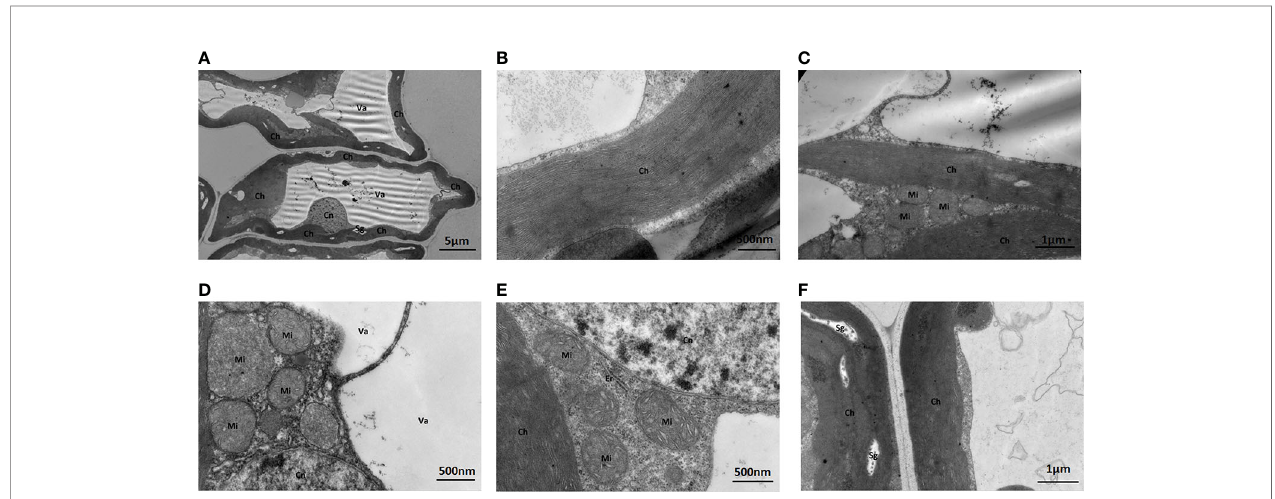
FIGURE 6 | Effect of solid MS culture medium with Na 2 MoO 4 on cell morphology and ultrastructure in leaf of strawberry seedlings. (A) The whole cell with organelles. (B) Stroma lamella and grana lamella in chloroplast. (C) the well developed chloroplasts. (D) the well-developed membrane of Mi and Cn, with mitochondrial cristae. (E) Er, Mi, Cn, and Ch of strawberry seedling grown with MoO 42- (F) The well-developed chloroplast with several Sgs. Ch, chloroplast; Cn, cell nucleus; Er, endoplasmic reticulum; Mi, mitochondria; Va, vacuole; Sg, starch